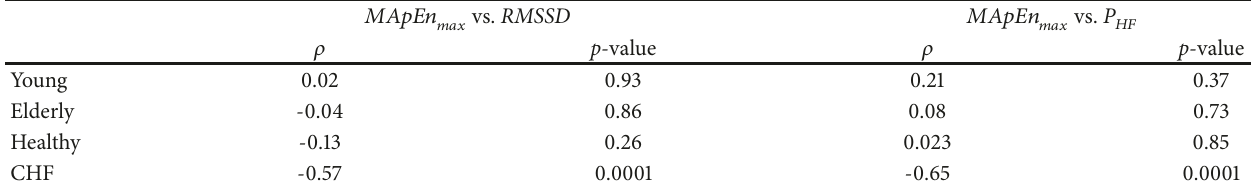
Table 2: Spearman correlation coefficients between 𝑀𝐴𝑝𝐸𝑛 𝑚𝑎𝑥 and RMSSD and between 𝑀𝐴𝑝𝐸𝑛 𝑚𝑎𝑥 and P